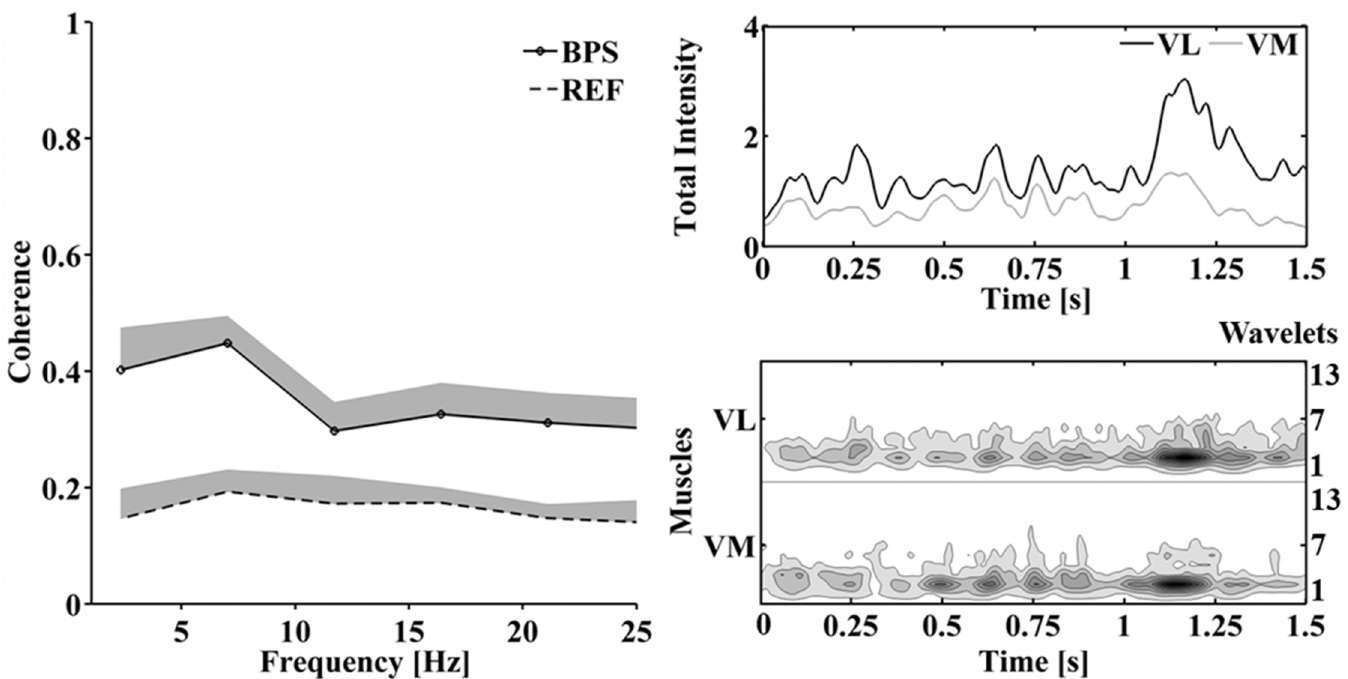
Fig 7. Coordinated oscillations in the global muscle activation intensity of VM and VL. Average coherence spectra (+SE) between total intensities of VM and VL during a bipedal squat (BPS) of one representative participant compared to the reference coherence (REF) (a); total intensities (b) and intensity patterns (c) of VL and VM during one bipedal